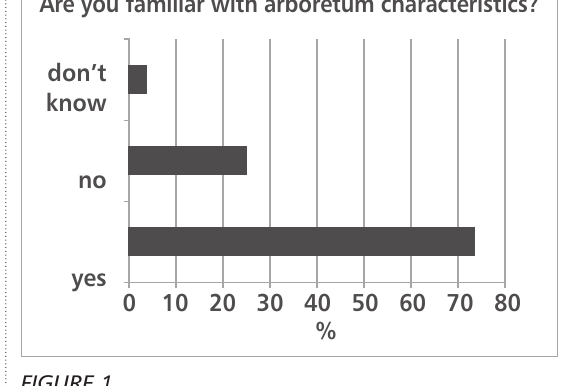
Familiarity with arboretum conditions